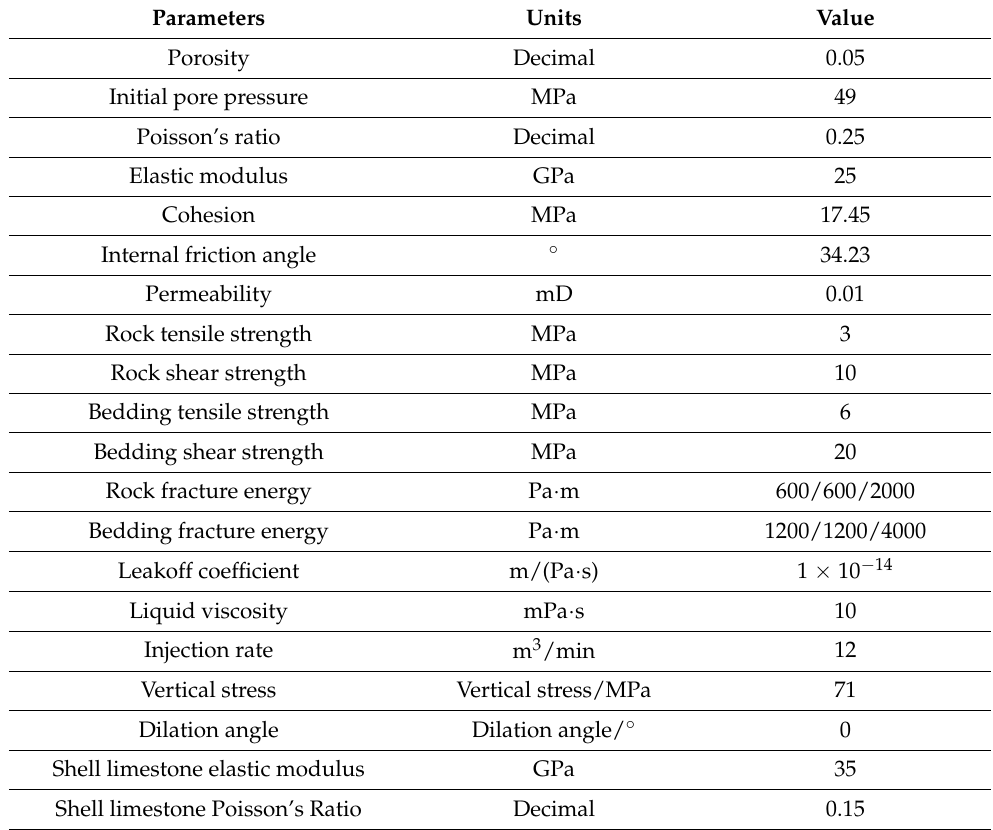
Table 1. Input parameters in numerical simulation on HF height growth in the shale oil